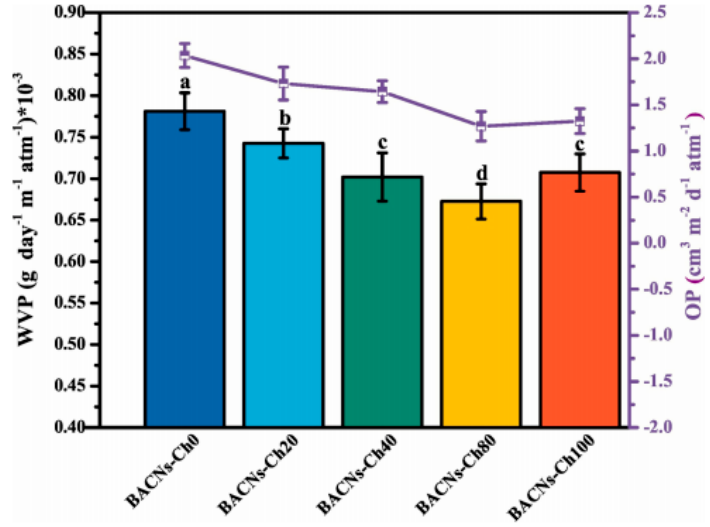
Figure 24. Water vapor permeability and oxygen permeability of BACNs-Ch films [97].